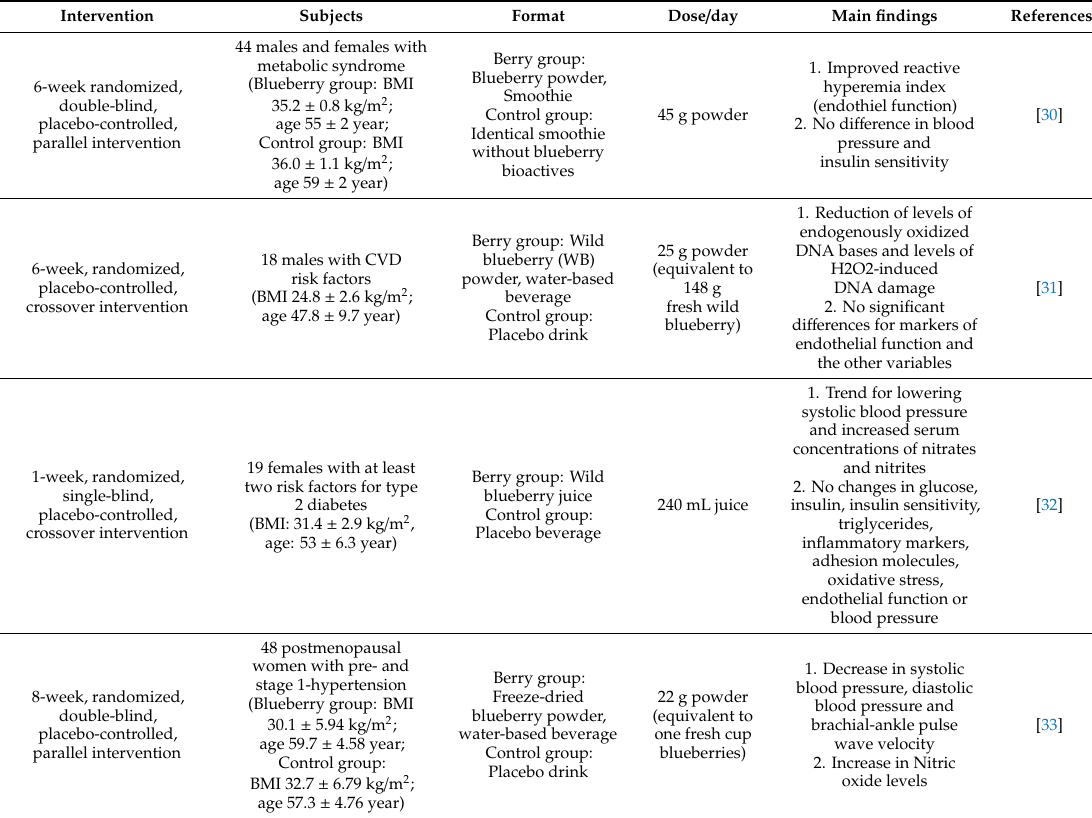
Table 3. E ff ect of blueberry consumption on cardiovascular disease, metabolic syndrome, cognitive function, mood and associated risk